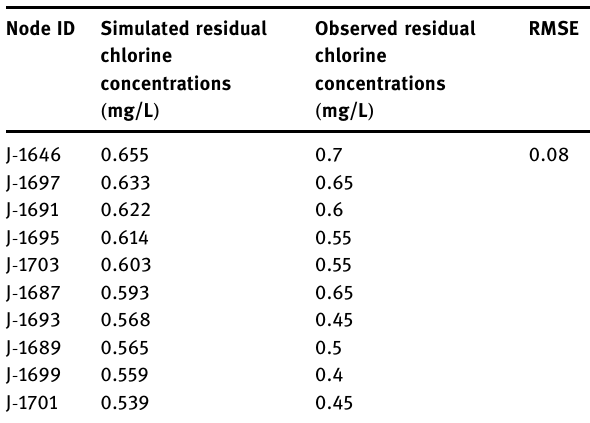
Table 2: Comparison between simulated and observed residual chlorine concentrations